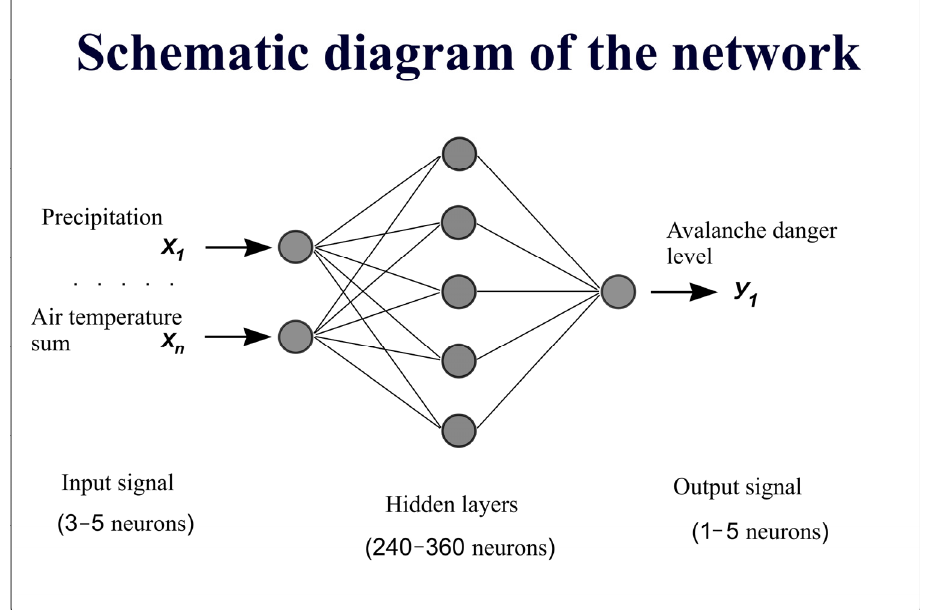
Figure 3. A schematic diagram of the arti fi cial neural network .